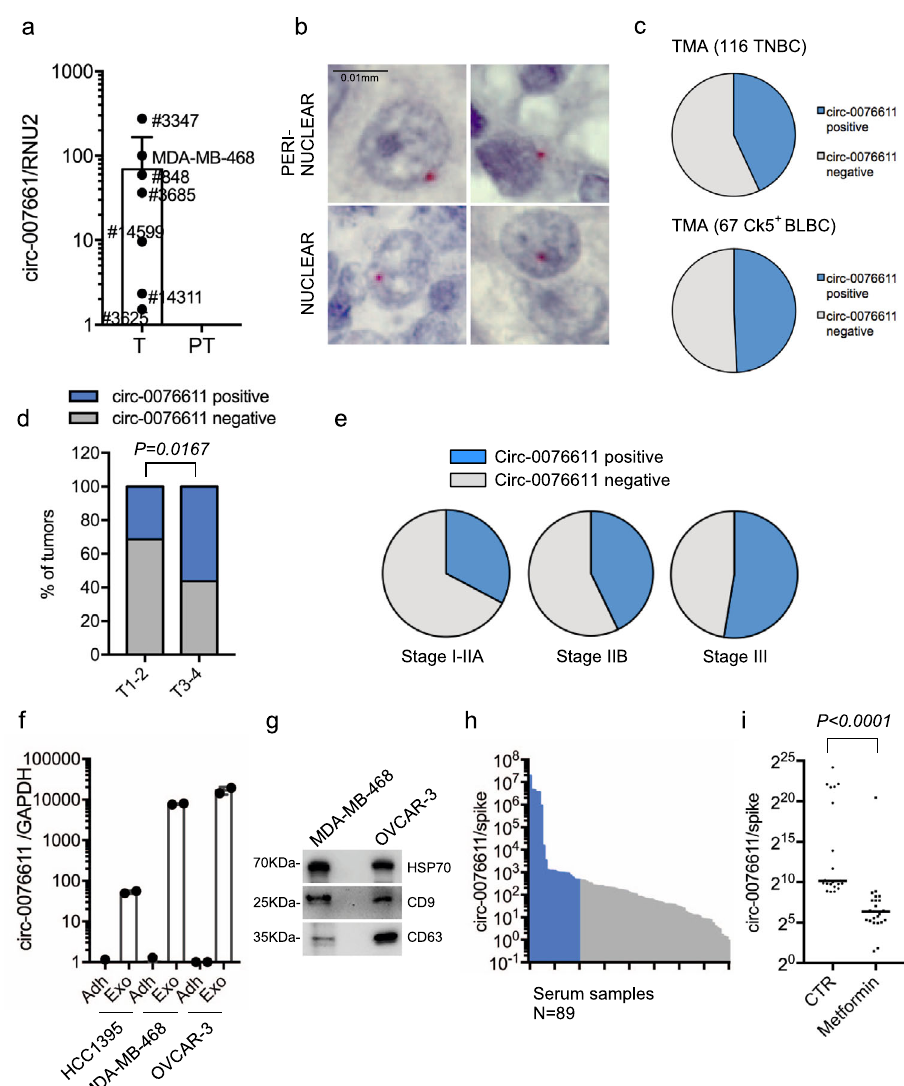
Fig. 2 Circ_0076611 is expressed in triple-negative breast cancer tissues. a RT-qPCR analysis of circ_0076611 in fresh frozen ER-negative breast cancer tumor (T) and matched adjacent peritumor (PT) tissues. b Detection of circ_0076611 by in situ hybridization (ISH) in breast cancer sections of a tissue microarray (TMA) containing triple-negative breast cancer (TNBC) cases. Scale bar 0.01 mm. c Distribution of circ_0076611 expression, as evaluated by ISH, in 116 TNBC tissues and in a subgroup of 67 Cytokeratin-5 positive (Ck5 + ) sections from the tissue microarray. d Percentages of circ_0076611- positive and -negative tumors from the TMA characterized by different size (T1 – T2 or T3 – T4) ( N = 105). Two-tailed p value has been calculated by Chi- square test comparing circ_0076611-negative vs. circ_0076611-positive cases, in the two groups with different tumor size T1 – T2 and T3 – T4. e Percentages of circ_0076611-positive and -negative tumors in groups with different tumor stage. f , g Expression of circ_0076611 (log 10 ), evaluated by RT-qPCR, in the indicated cell lines (Adh) and in matched exosomes isolated from their conditioned media (Exo) ( f ). Western blot analysis of exosomal markers HSP70, CD9, CD63 has been carried out as quality control for exosomes puri fi cation ( g ). Bars indicate standard error. h Expression of circ_0076611 (log 10 ), evaluated by RT-qPCR, in the sera of women with established breast cancer ( N = 89). Samples belonging to the upper quartile are indicated in blue. i Scatter plot showing the level of circ_0076611, evaluated by RT-qPCR, in the sera of patients with established breast cancer collected before (indicated as CTR) and after (indicated as Metformin) a 3-months daily treatment with metformin (500 mg day − 1 ) as agent with anticancer activity within a randomized clinical trial 31 . The presented data are from patients ( N = 23) belonging to the upper quartile of the cohort, indicated in blue in h . **** p < 0.0001. p value has been calculated using Wilcoxon matched-pairs signed rank